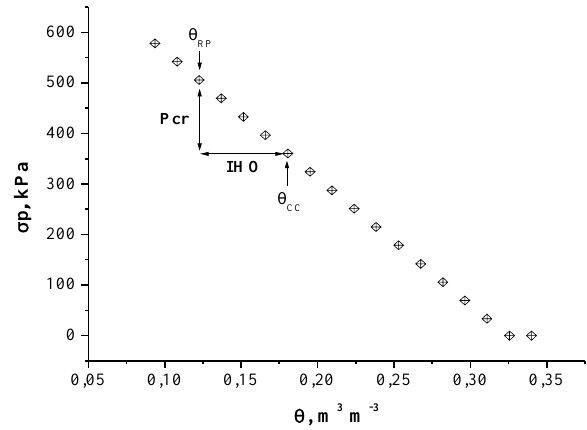
Figura 3. Variação da capacidade de suporte de carga do solo ( sssss ) com a umidade volumétrica p ( qqqqq ), para um valor de densidade do solo crítica igual a 1,70 Mg m -3